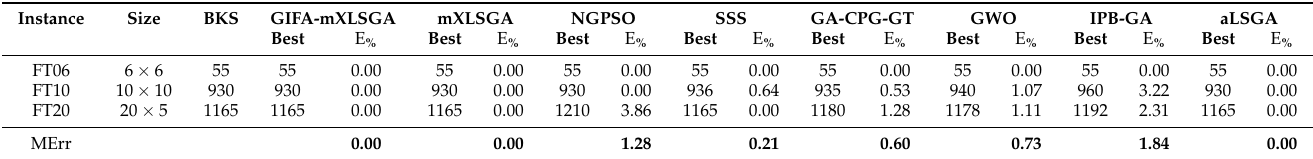
Table 2. Comparison of computational results between GIFA-mXLSGA and other algorithms for FT. The symbol “-” means “not evaluated in that instance”.